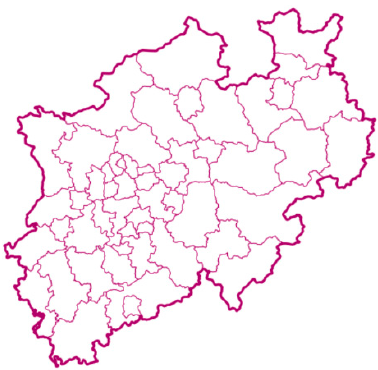
Figure 2. Simple vector data of the state of North-Rhine Westphalia (NRW) in Germany with sub-polygons representing cities and counties [17].